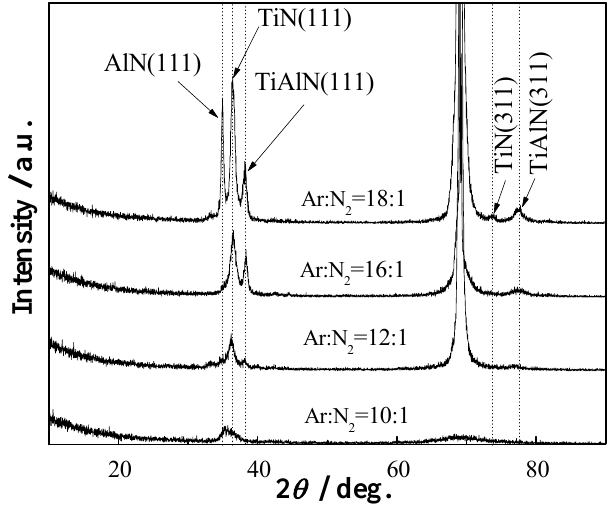
Figure 2. X-ray diffractometer (XRD) patterns of TiAlN/Al Ar/N 2